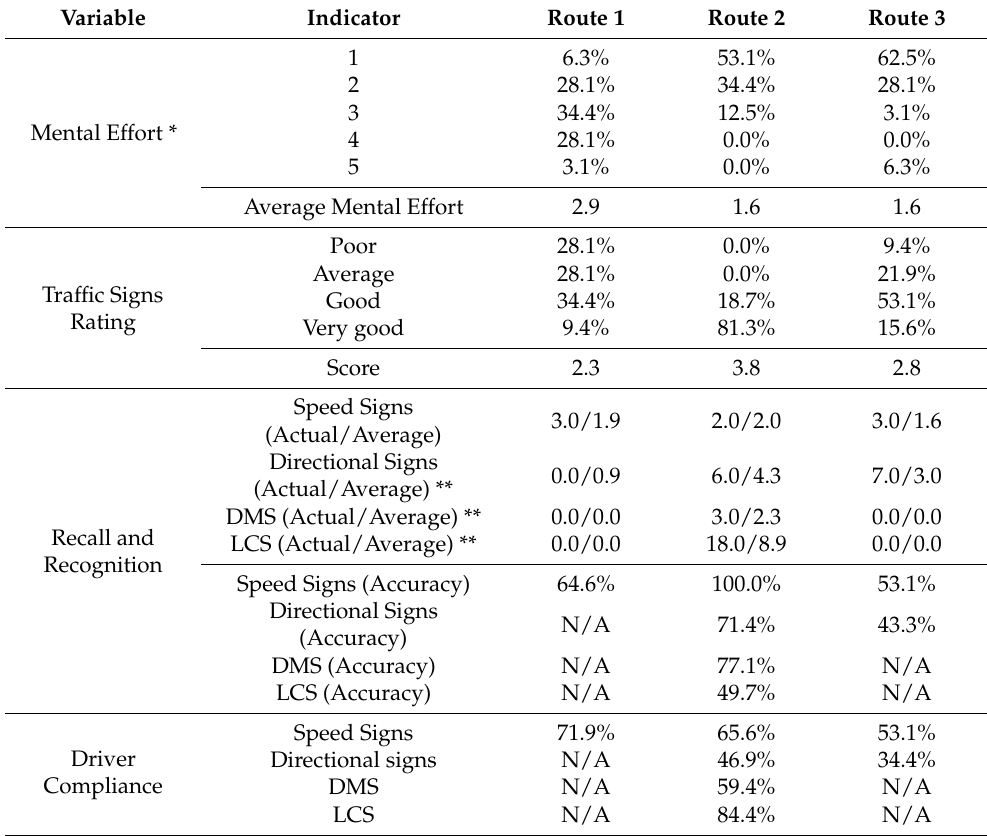
Table 6. Descriptive results of self-reported